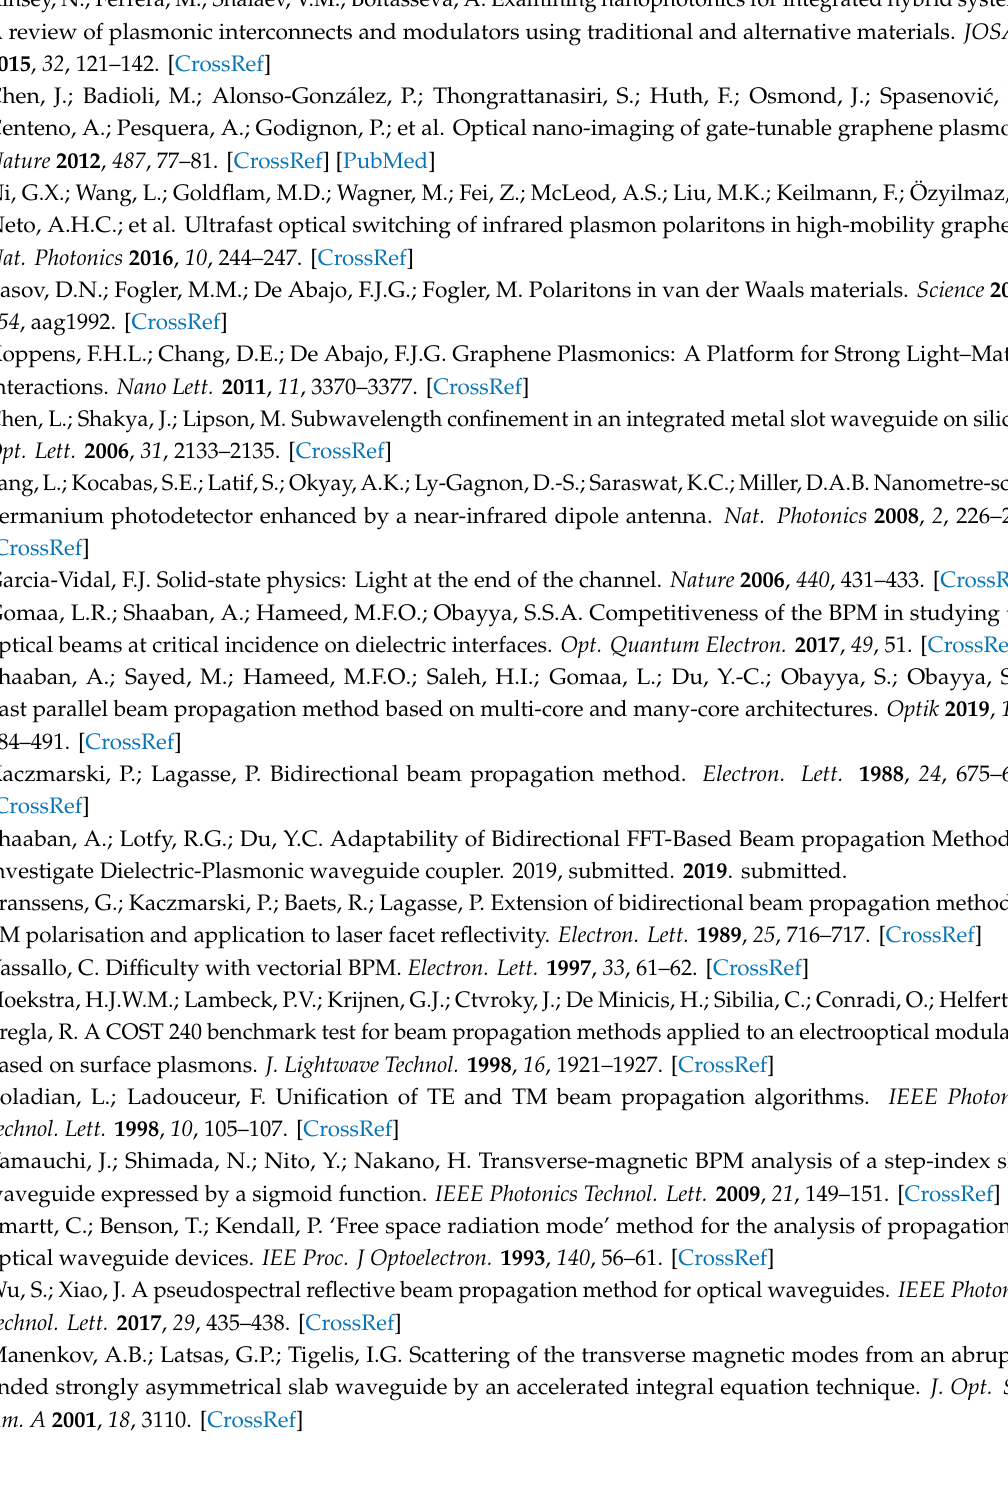
FFT-BPM: FFT-based Beam Propagation Method; TE: Transverse Electric; TM: Transverse Magnetic; MIM: metal insulator metal; FDFD: finite di ff erence frequency domain; TM0: transverse magnetics fundamental mode; PWE: plane wave expansion, TMM: Transfer Matrix